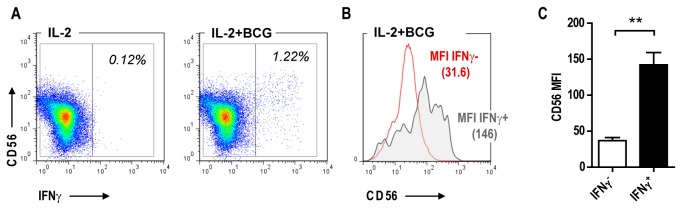
IFN-γ producing NK cells in response to mycobacteria express higher
levels of CD56.Human NK cells were cultured in the presence of IL-2 (100U/ml) and/or
M.
bovis BCG (MOI 1:1) for a total of 24h
including Brefeldin A treatment. A) FACS dot-plot showing the gating
strategy to distinguish IFN-γ producing NK cells following BCG
stimulation. B) CD56 overlay histogram comparing the expression of CD56
between IFN-γ producing and non-producing NK cells. C) Bar graph showing
significant increase of CD56 mean fluorescence intensity (MFI) from
IFN-γ producing NK cells following BCG stimulation across different
donors (n=4, mean +/- SD, paired t test, **p<0.01).